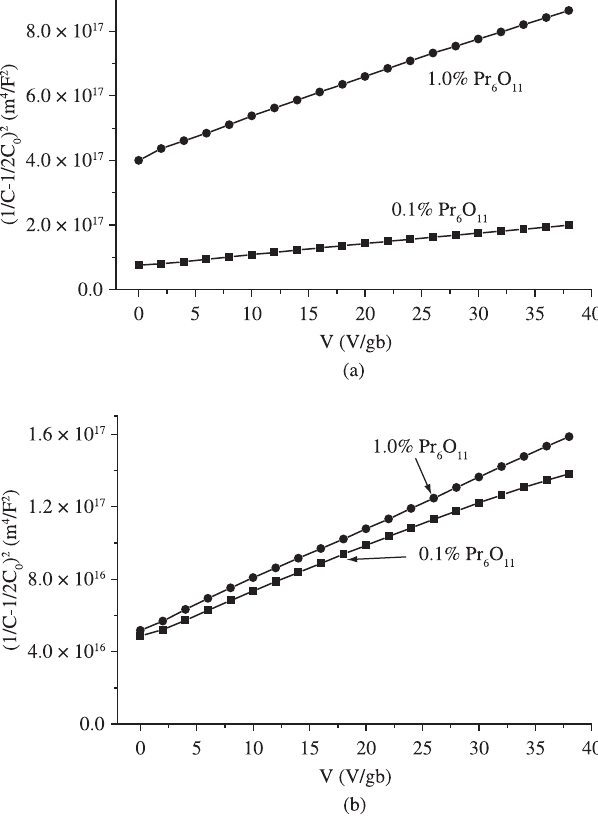
Figure 6. Mott-Schottky behavior without charge transport influence (true Mott-Schottky behavior) of ZPC varistors systems with different content of Pr O additive and sintered at: a) 1300 and b) 1350 6 11